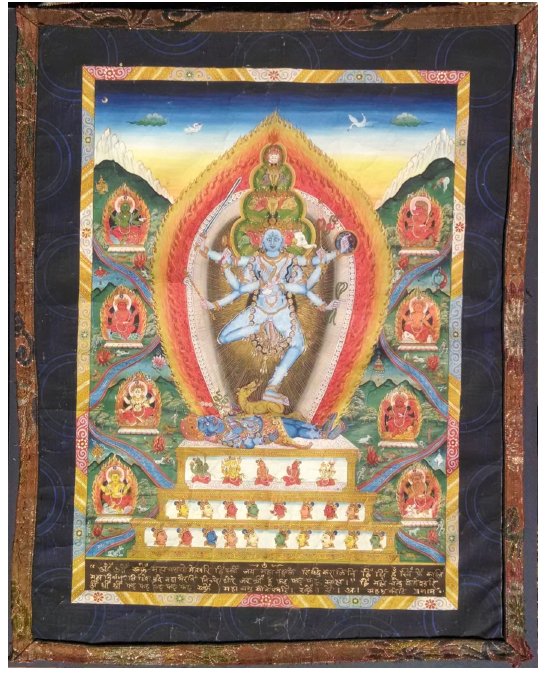
Figure 2. Guhyak ā l ī